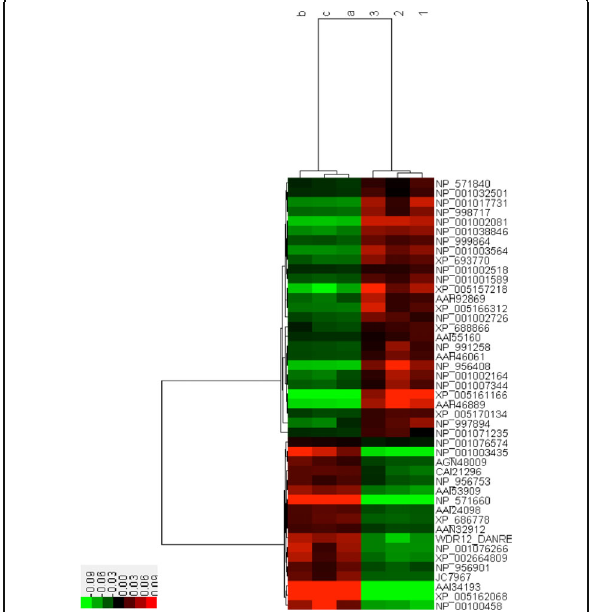
Fig. 12 Cluster (heatmap) of MS identification results comparison between oridonin groups and control